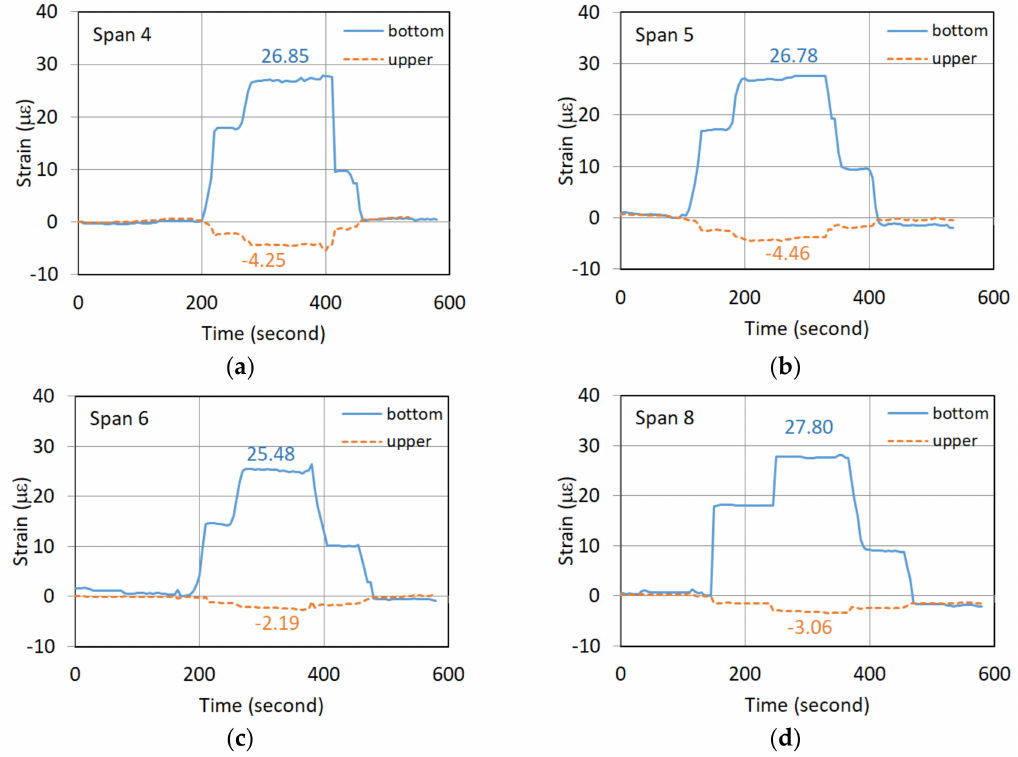
Figure 5. Strain responses of northward spans during the static test: ( a ) Span 4; ( b ) Span 5; ( c ) Span 6; ( d ) Span